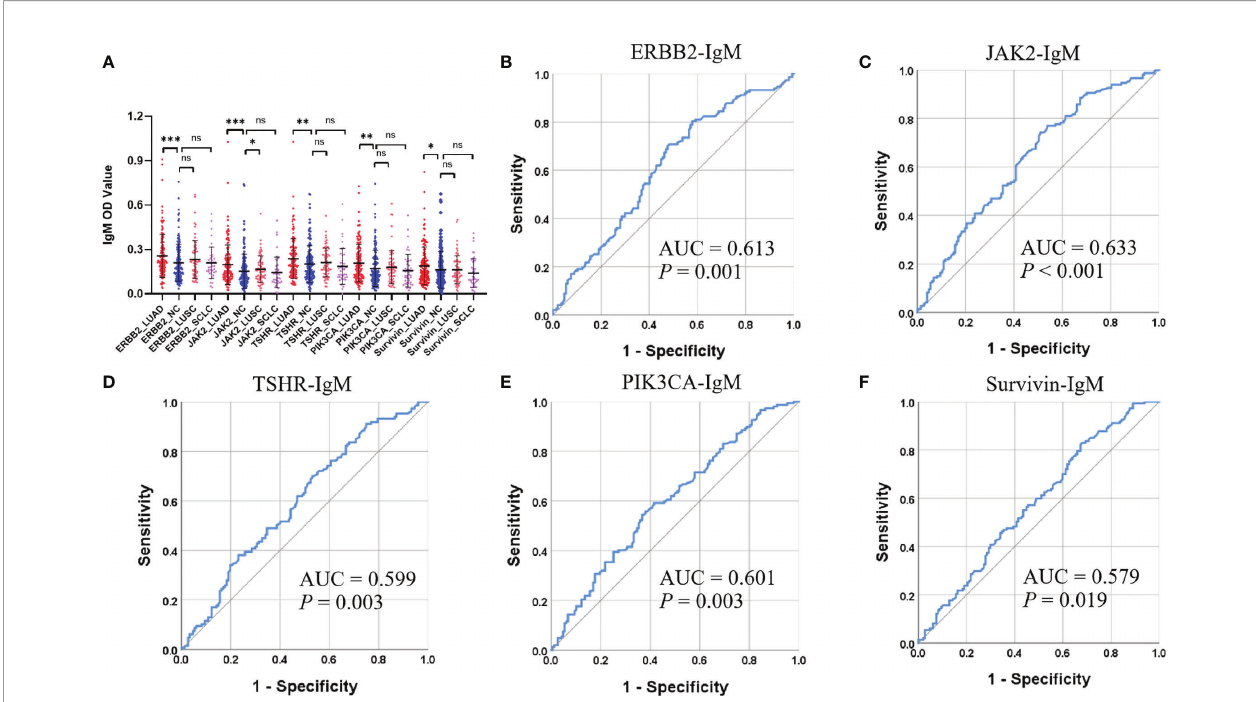
FIGURE 5 | (A) Differential expressions of the top 5 (AUC ranking) IgM autoantibodies in the validation cohort using ELISA. *** p < 0.001, ** p < 0.01, * p < 0.05, nsp > 0.05. (B – F) ROC analysis (LUAD and NC) of the top 5 IgM autoantibodies in the validation cohort. AUC, area under the receiver operating characteristic